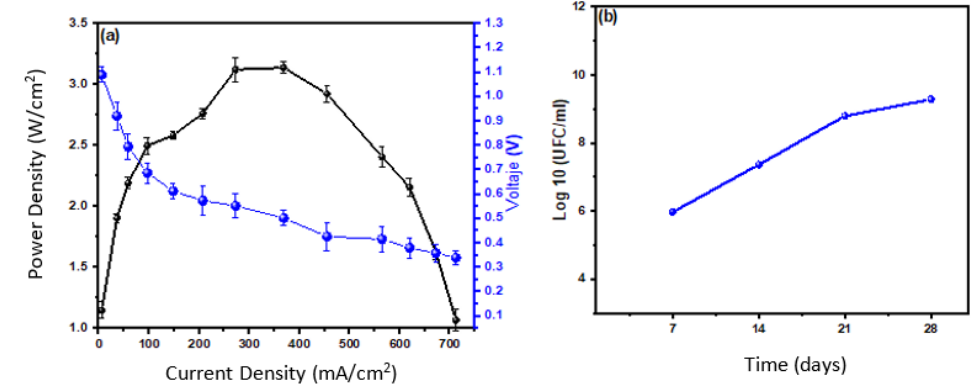
Figure 4. Values of ( a ) current density, power density and voltage, and ( b ) yeast growth in microbial fuel cells.